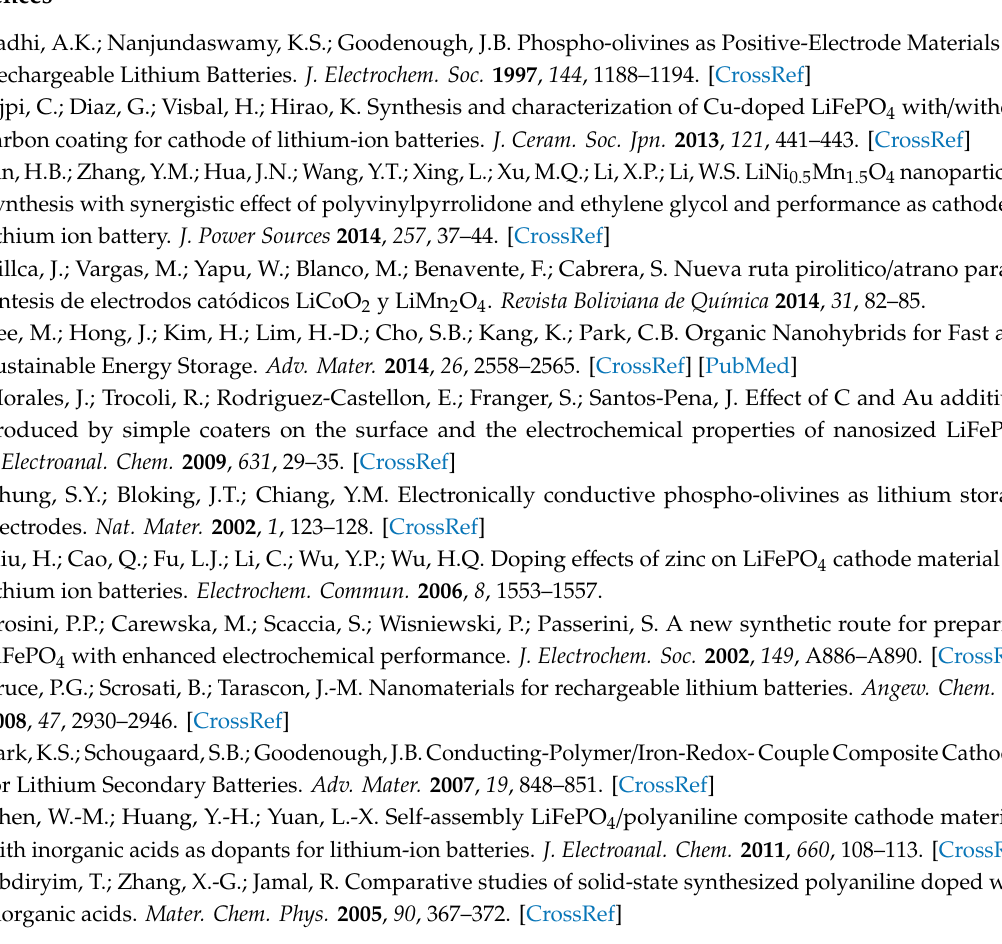
Figure S1: Mechanism of aniline polymerization in the synthesis PANI. Figure S2: Morphology of PANI, a, upper) illustration of primary particles and agglomerates, b, lower) SEM images of the synthesized PANI agglomerates and enlargement showing the globular morphology. Figure S3: EDS spectrum of the PANI. Figure S4. FTIR spectra for PANI. Figure S5. Possible structure of the PANI and its interactions. Figure S6. Possible qualitative reactions of the decomposition of the PANI during the TG analysis. Figure S7. Possible qualitative reactions of the decomposition of the LiFePO 4 -PANI during the TG analysis. Figure S8. Electrochemical performance of PANI: cycling performance profiles. Figure S9. Electrochemical performance of PANI: galvanostatic discharge-charge profiles. Figure S10. Cell voltage as a function of time at di ff erent cycles obtained by charging and discharging at same rate for the LiFePO 4 -PANI. The data were obtained by charging and discharging at 0.1